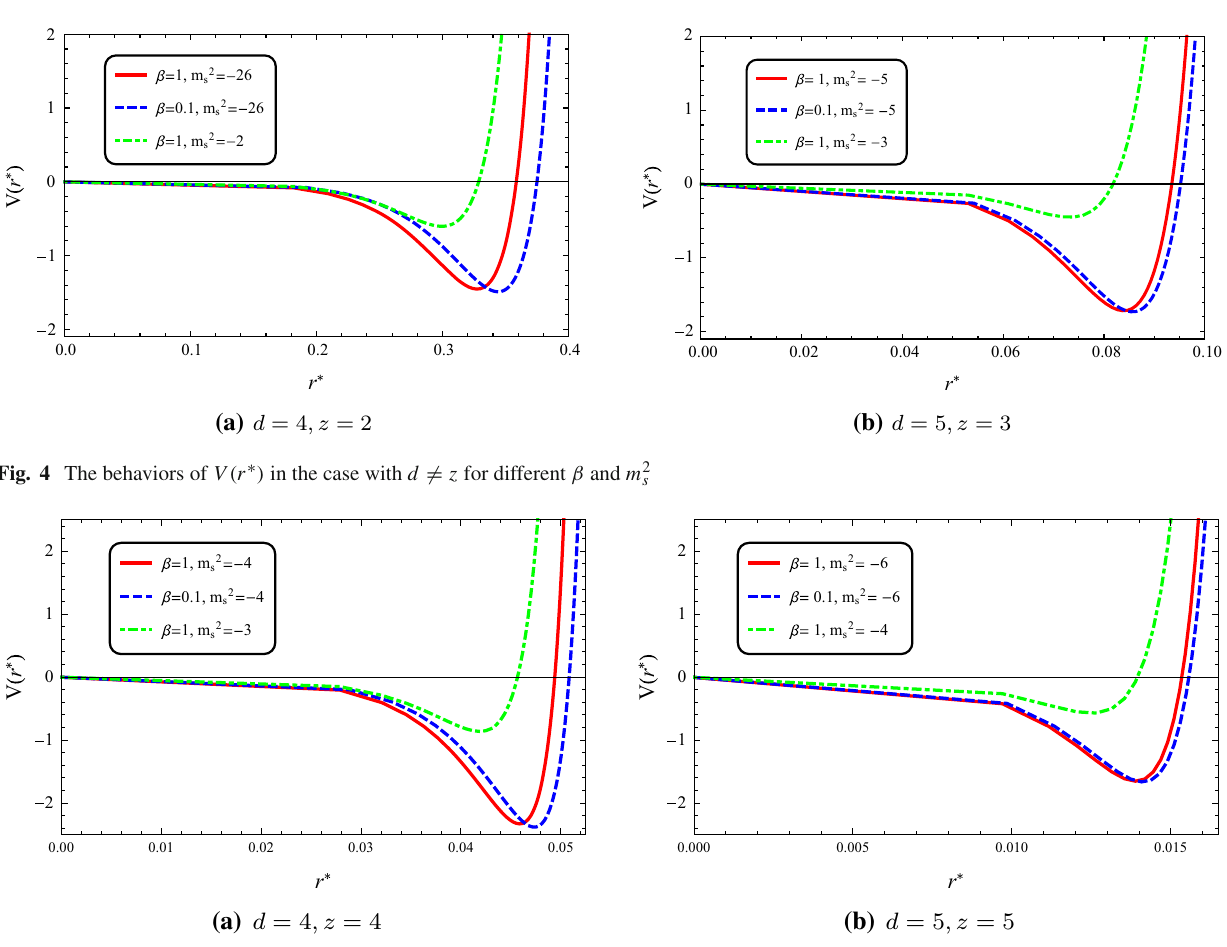
Fig. 5 The behaviors of V ( r ∗ ) in the case with d = z for different β and m 2 s different values of β first increases by increasing z and then